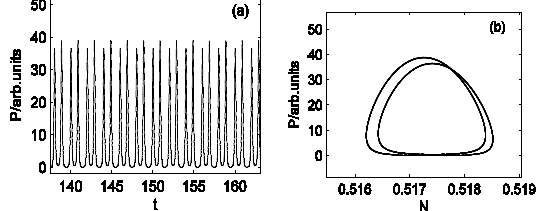
Fig. 7. A cycle-two. (a) a cycle-2 movement. (b) a cycle-2